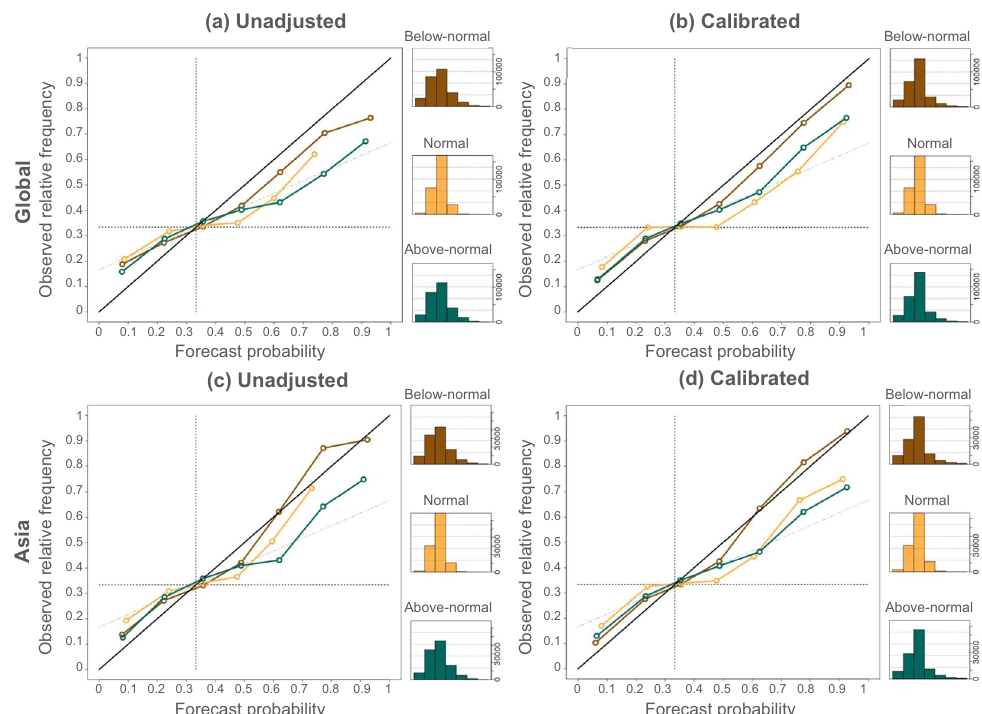
Fig. 2 Reliability of the drought index. Reliability diagrams (lines) for probabilistic categorical forecasts (tercile events) of unadjusted SPEI6 estimate ( a , c ) and for the calibrated index ( b , d ) over Global spatial domain (top) and Asia (bottom). The frequency of occurrence of each bin for each category is shown to the right of the